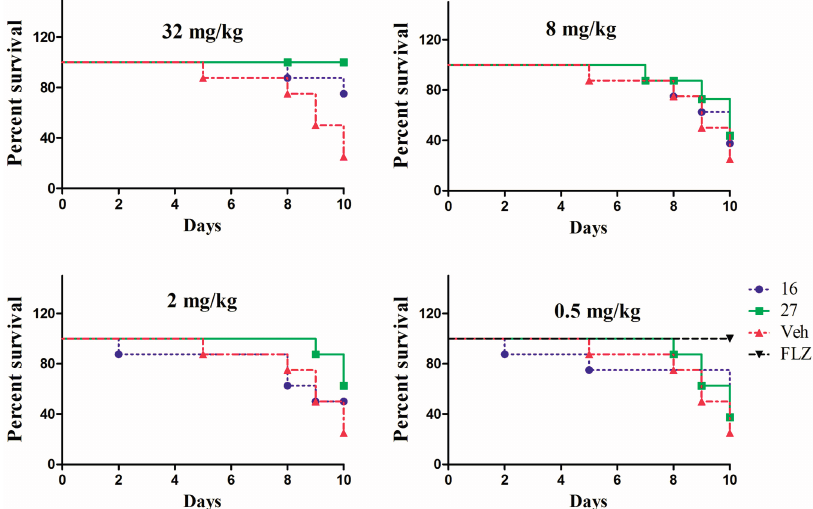
Figure 3. Survival rate of mice after injection with C. albicans ATCC 90028. FLZ stands for fluconazole and indicates a statistically significant difference compared to the control group. The four tested dosages of 31 and 42 were 32, 8, 2 and 0.5 mg/kg. The dosage of fluconazole was 0.5